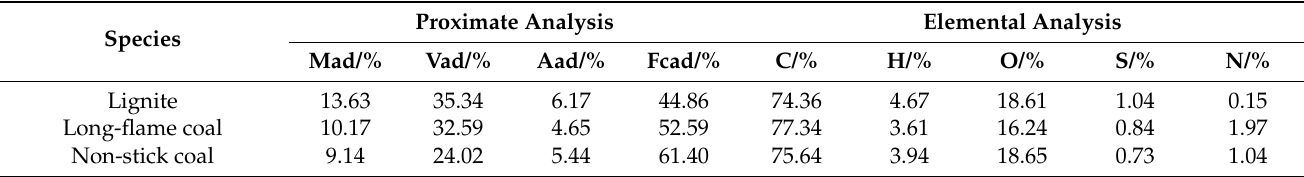
Table 1. Proximate and elemental